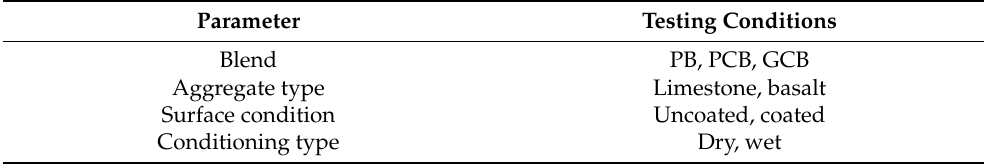
Table 5. BBS testing